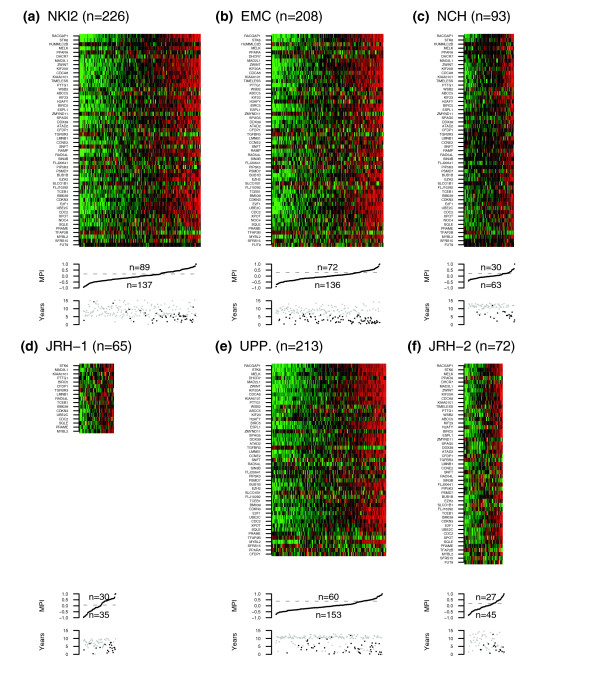
The MPI in the training and test cohorts. Heatmaps of relative gene expression (green = 'low', red = 'high') of the optimal 52-gene classifier and accompanying MPI distribution values across the three training cohorts (a) NKI2, (b) EMC and (c) NCH, and three test cohorts (d) JRH-1, (e) UPP and (f) JRH-2. The threshold shown for the MPI distributions was determined as explained in the text. Lower panels show the survival time distributions in the respective cohorts (black = 'death/poor outcome', grey = 'censored/good outcome').